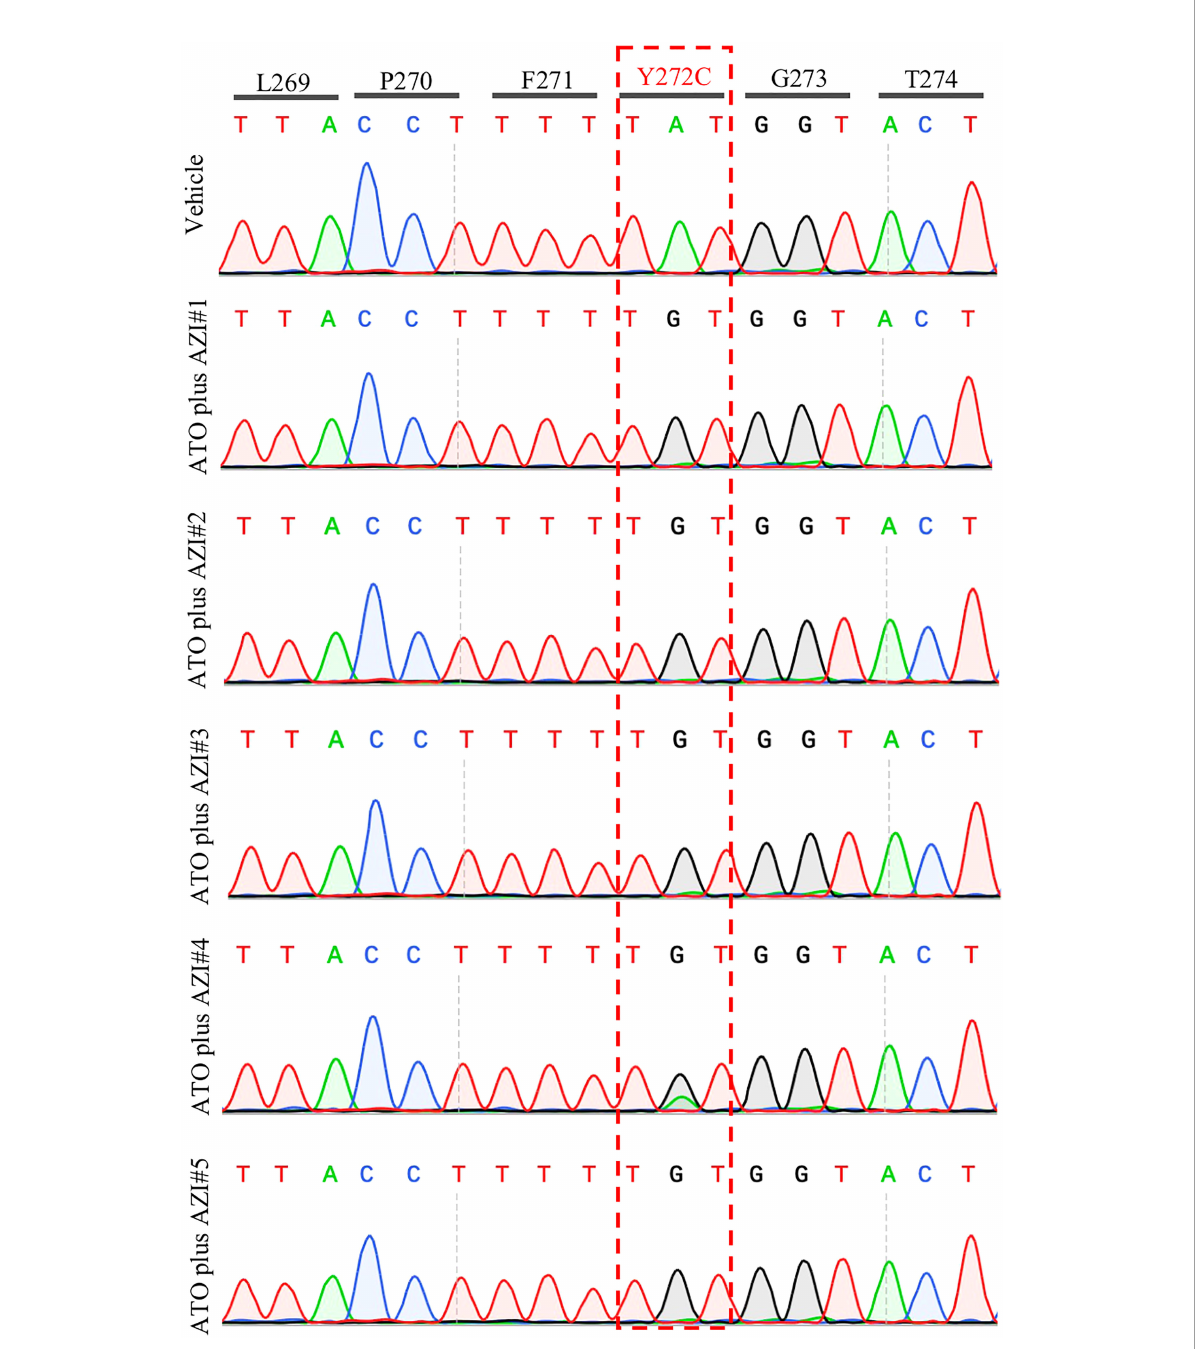
FIGURE 3 Representative sequencing chromatogram of cytochrome b ( Cytb ) gene in recrudescent parasites. The parasite DNA of vehicle #1 and ATO plus AZI (#1-5) were extracted from a blood sample at 92 days post-infection and was used to amplify and sequence the B. microti Cytb